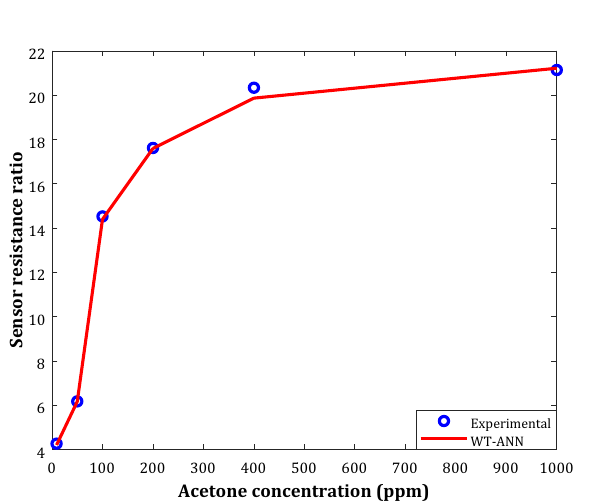
Figure 9. The influence of sensor chemistry and operating temperature on the acetone sensing (100 ppm).